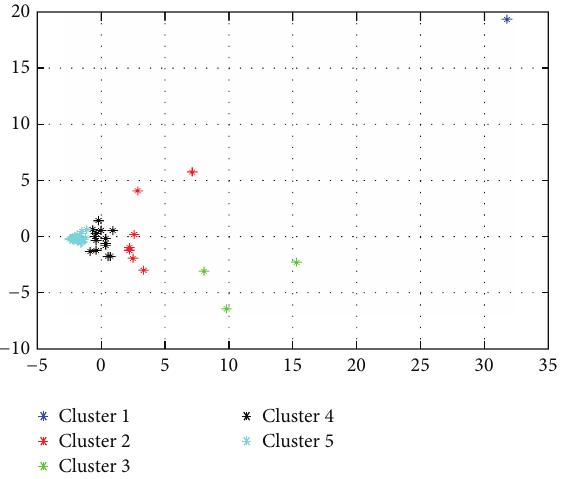
Figure 2: Clustering results.